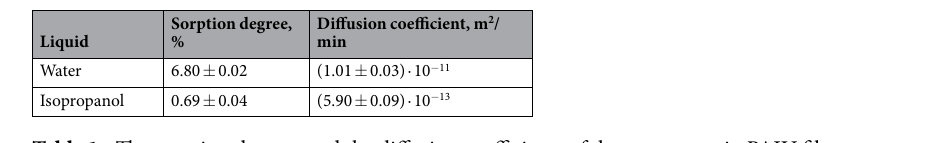
Table 1. The sorption degrees and the diffusion coefficients of the penetrants in PAIU